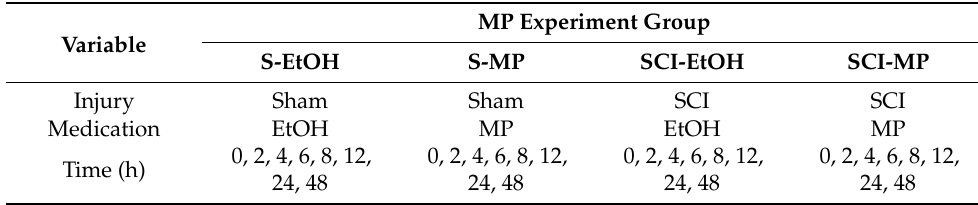
Table 1. Groups in the methylprednisolone experiment.